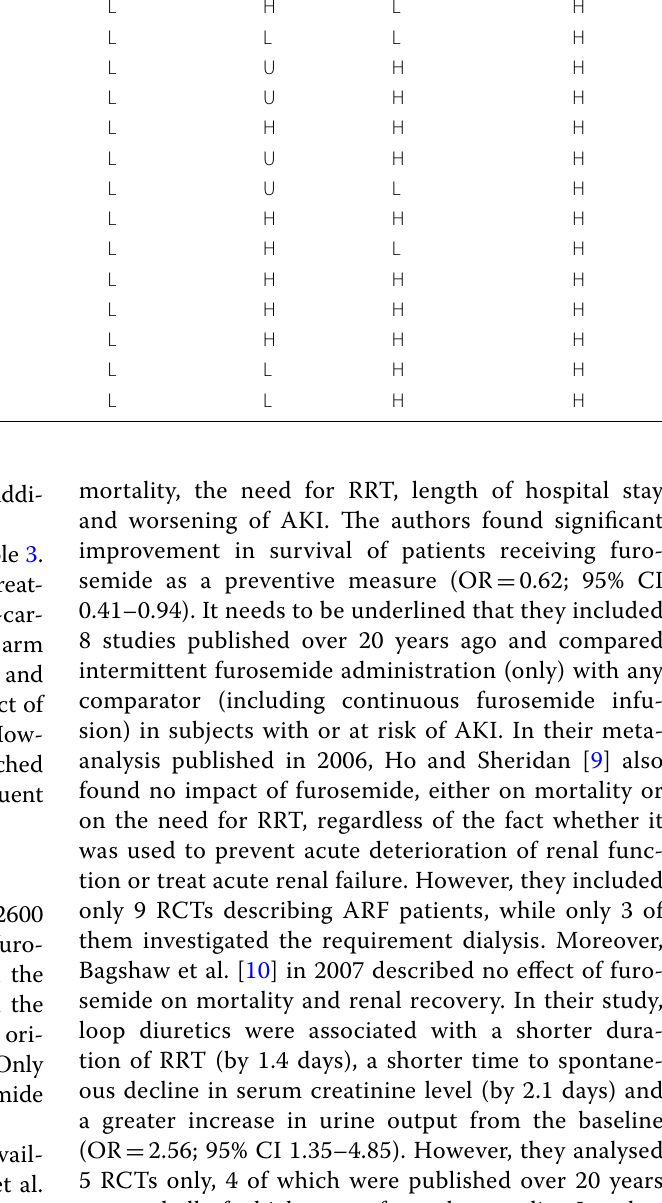
H high, L low, U unknown